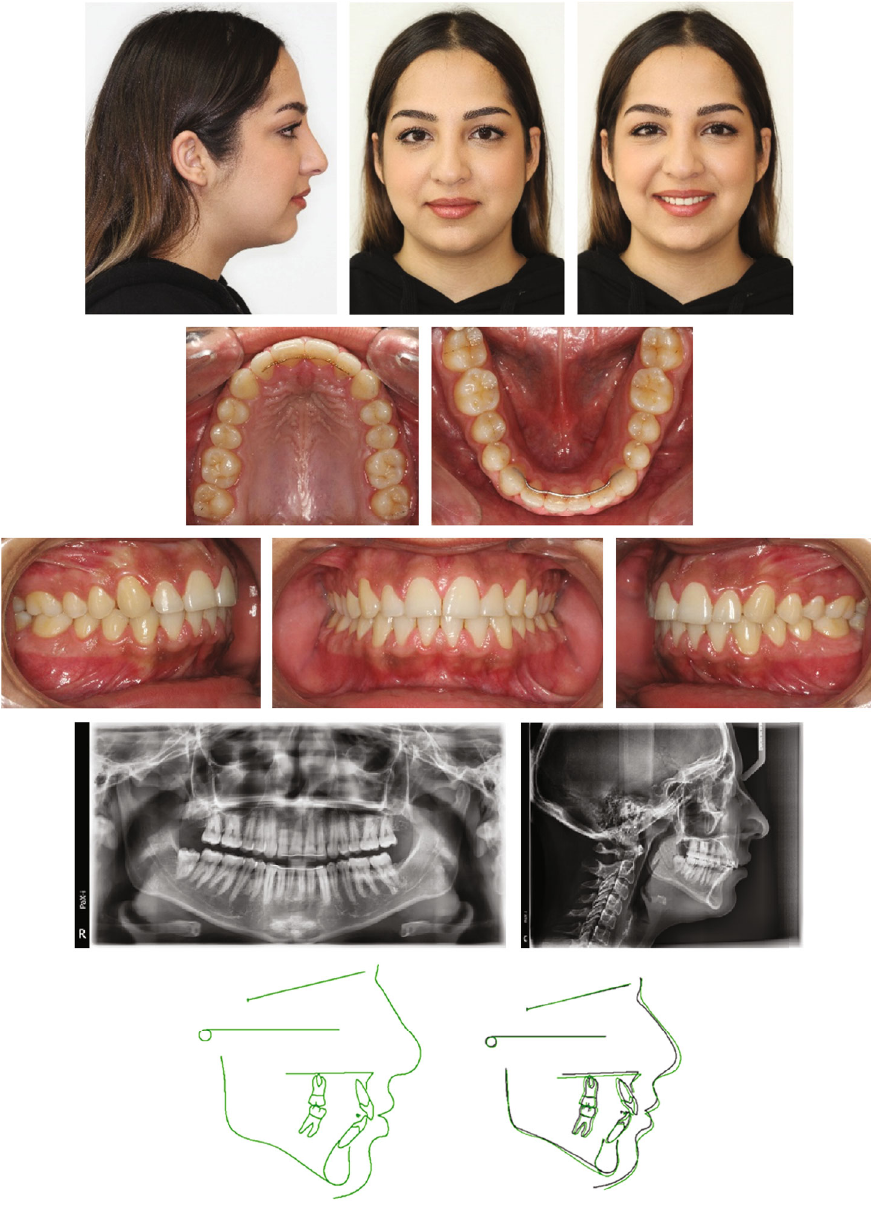
Figure 10: Case 1. Patient three years after